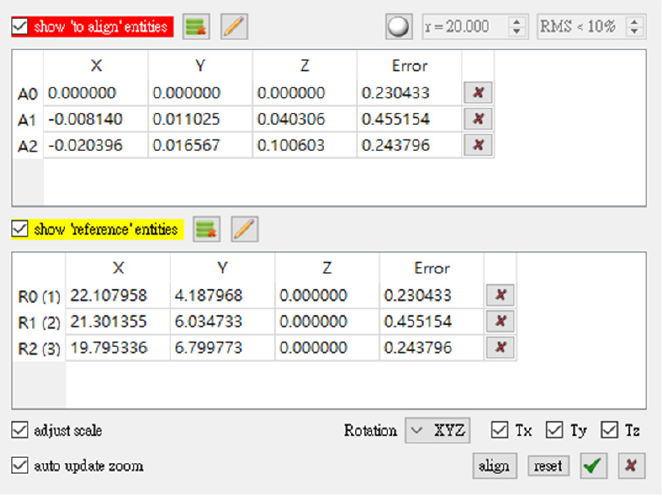
Figure 8. Schematic of 4PCS coordinate transformation.